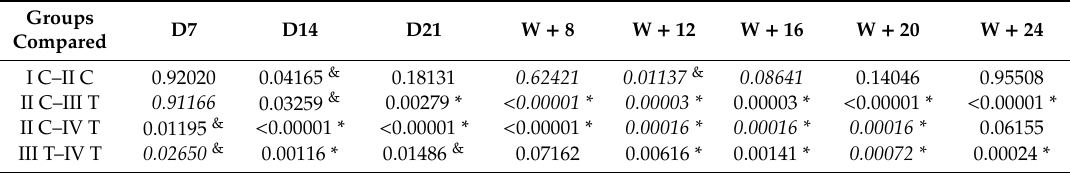
Table 3. Comparison of prostate volume changes between control and treated groups. To reliably monitor the prostate volume in the study groups despite breed and sizes di ff erences, the absolute values (cm 3 ) were converted into percentages (%). Prostate volume presented as percentage (%), where the initial (D0) volume was considered 100%.